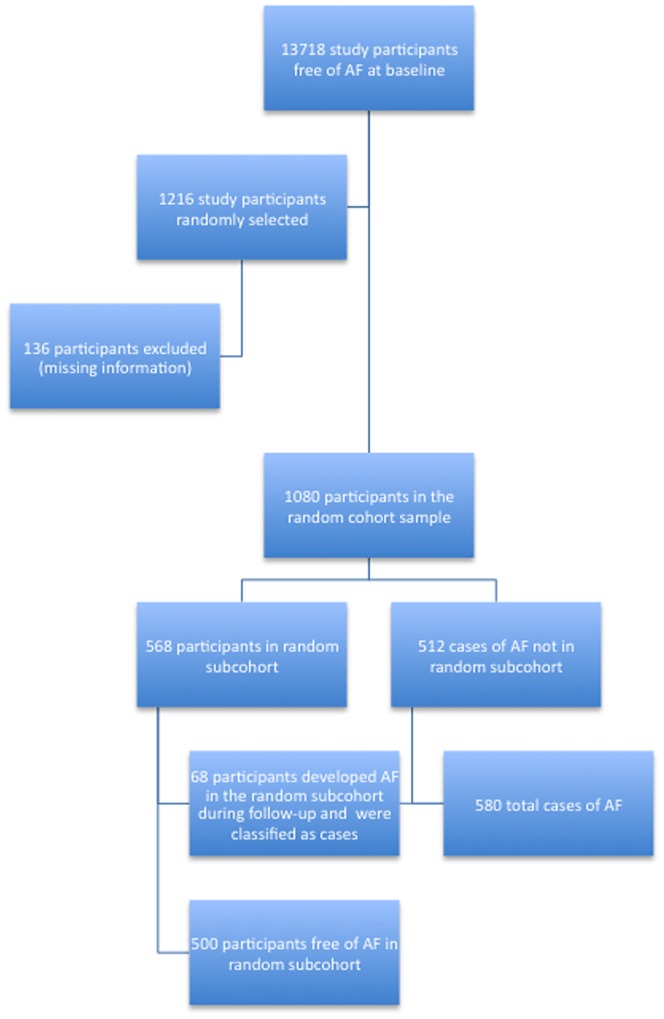
Flowchart of selection of cases and the random subcohort in the Atherosclerosis Risk in Communities Study.